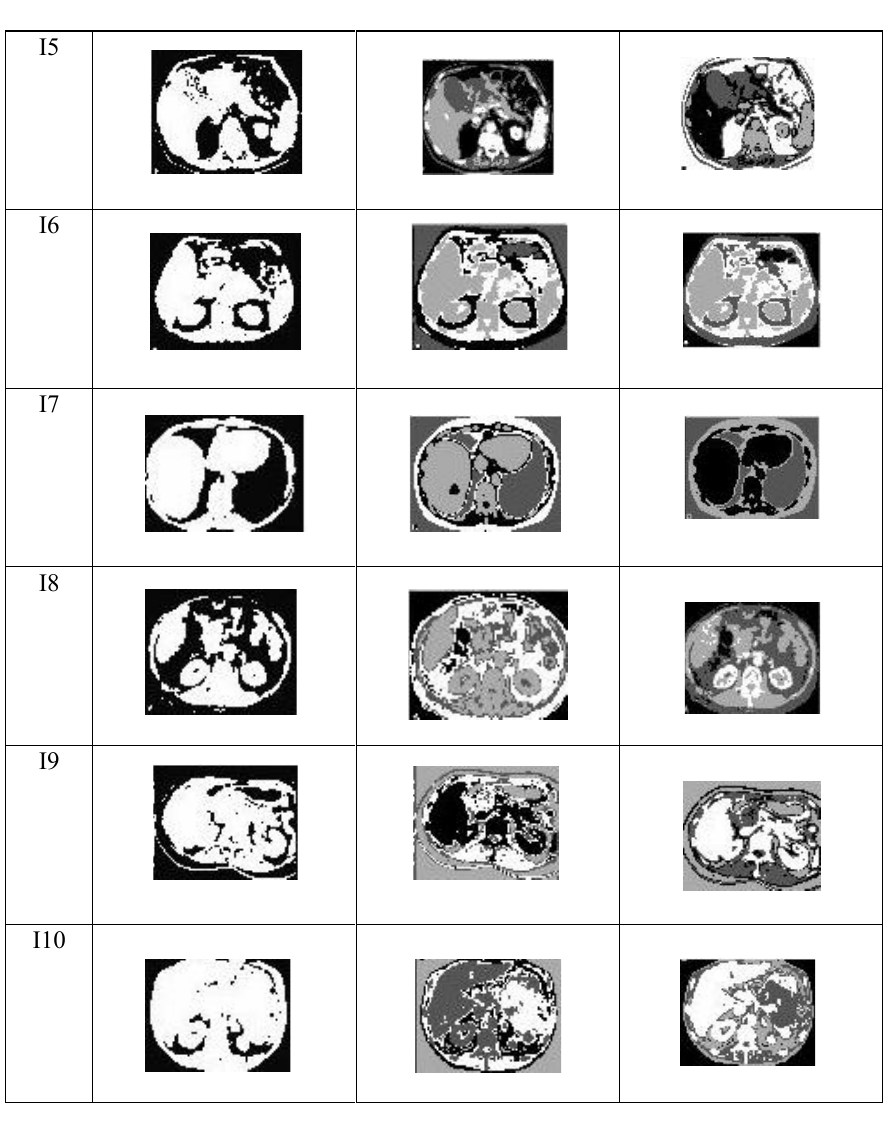
Figure 11. Resultant CT Images after Fuzzy C Means Clustering and Artificial Intelligence (GA and PSO)